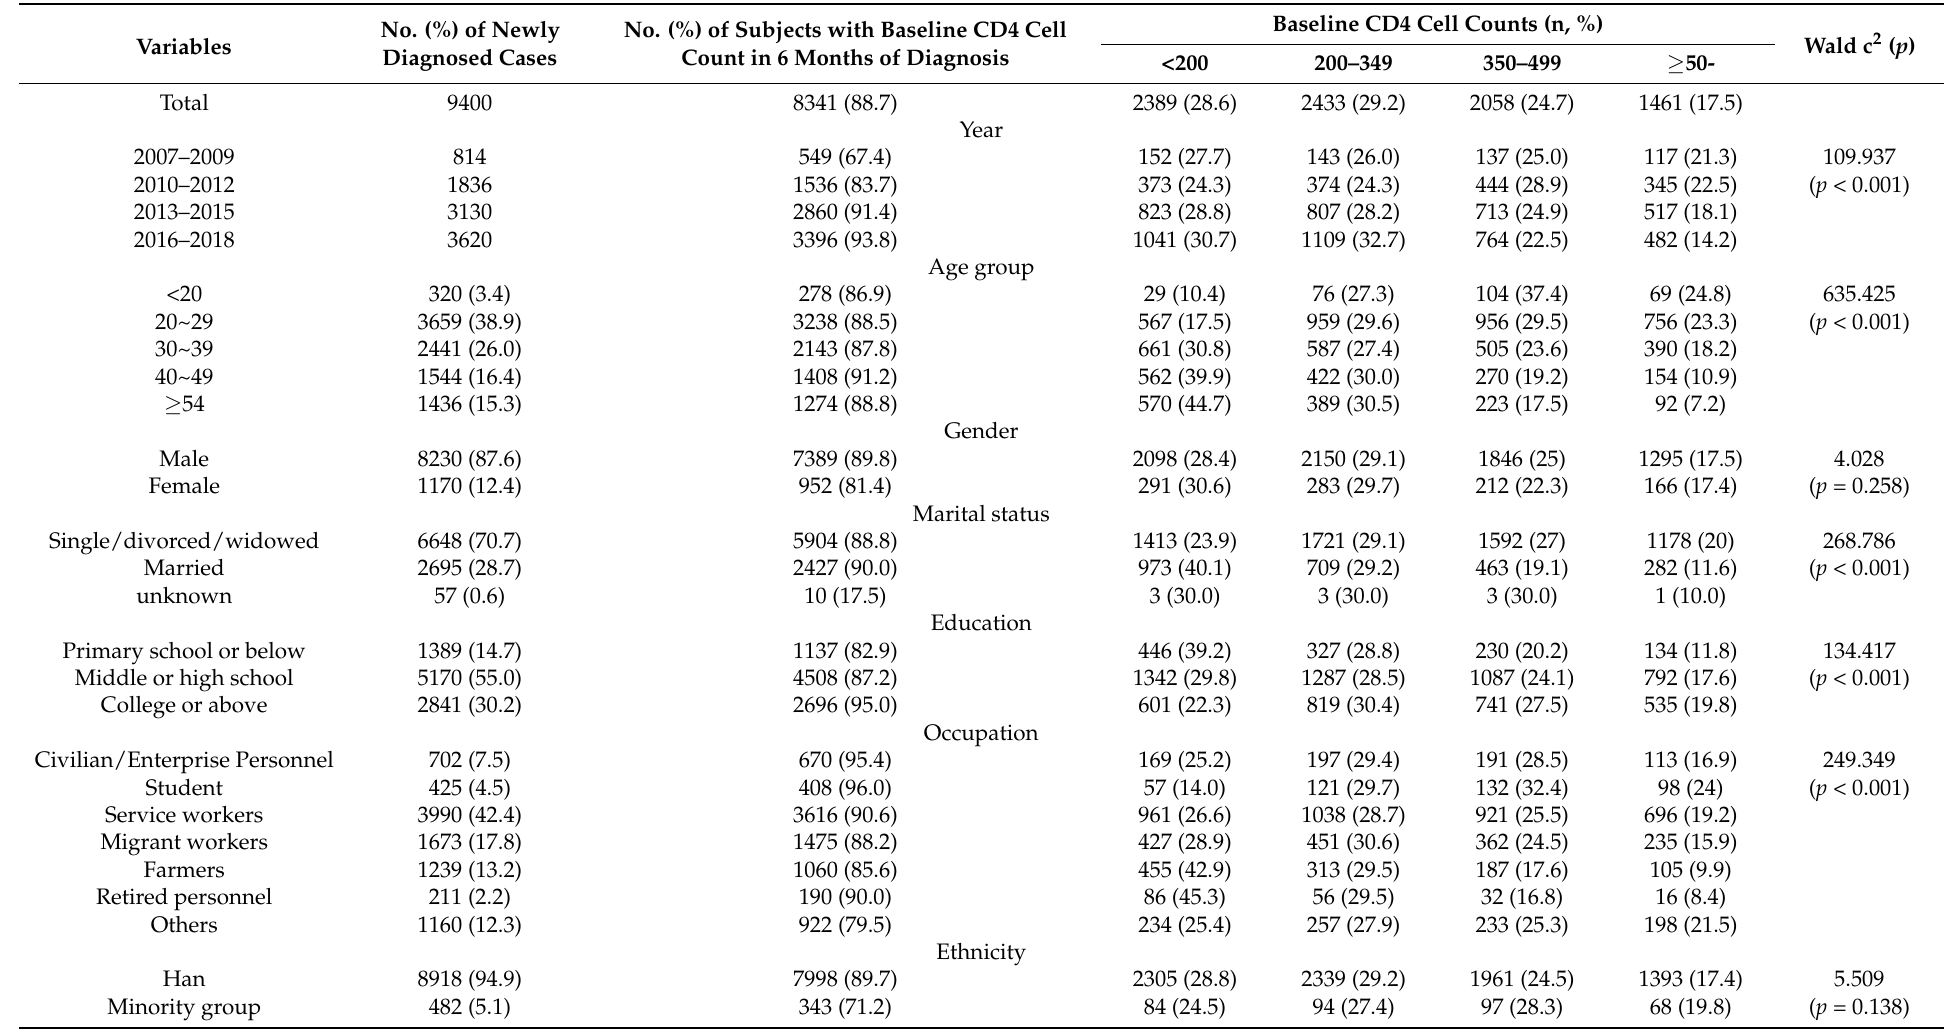
Table 2. Distribution of baseline CD4 cell count(cells/ul) of HIV newly diagnosed cases in 6 months of diagnosis in Hangzhou,